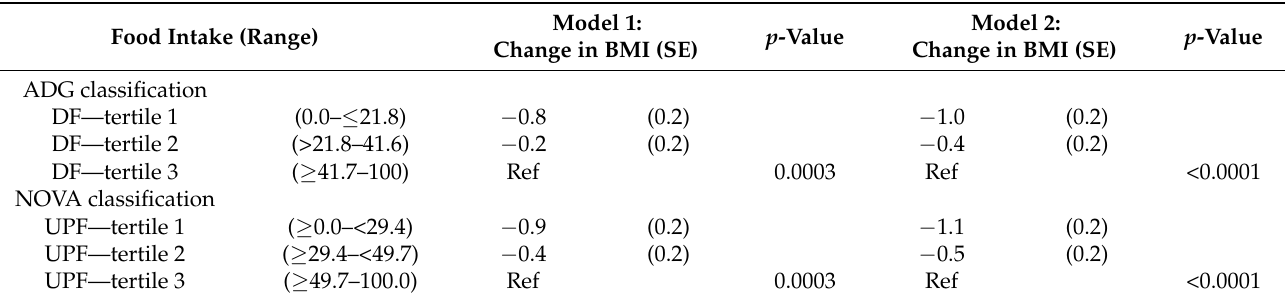
Table 5. Change in body mass index (BMI) with changes in intake of discretionary food as defined by the Australian Dietary Guidelines (ADG) and ultra-processed food (UPF) as a proportion of energy as defined by the NOVA classification